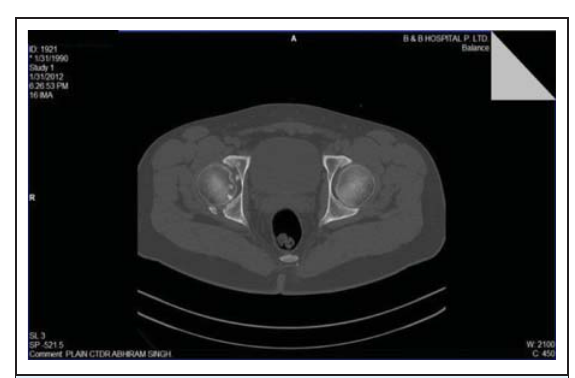
Figure 7. 22Y/M: Axial CT image shows isolated pos- terior wall fracture of right acetabulum and intraar- ticular loose